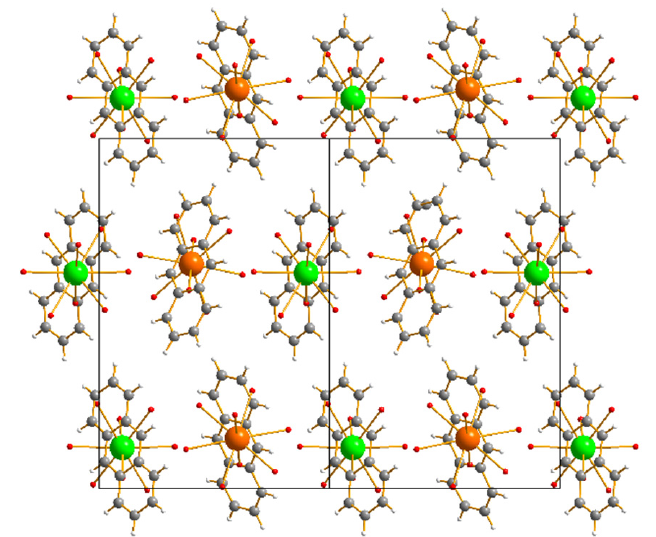
Figure 4. Overall view with K1 = green and K2 = orange. If all the atoms were shown, the packing would be so dense as to render the figure nearly useless. By showing (in red) the crown ether oxygen atoms only, one obtains a more informative picture of the packing; the remaining crown ether and furan atoms were eliminated for this view.